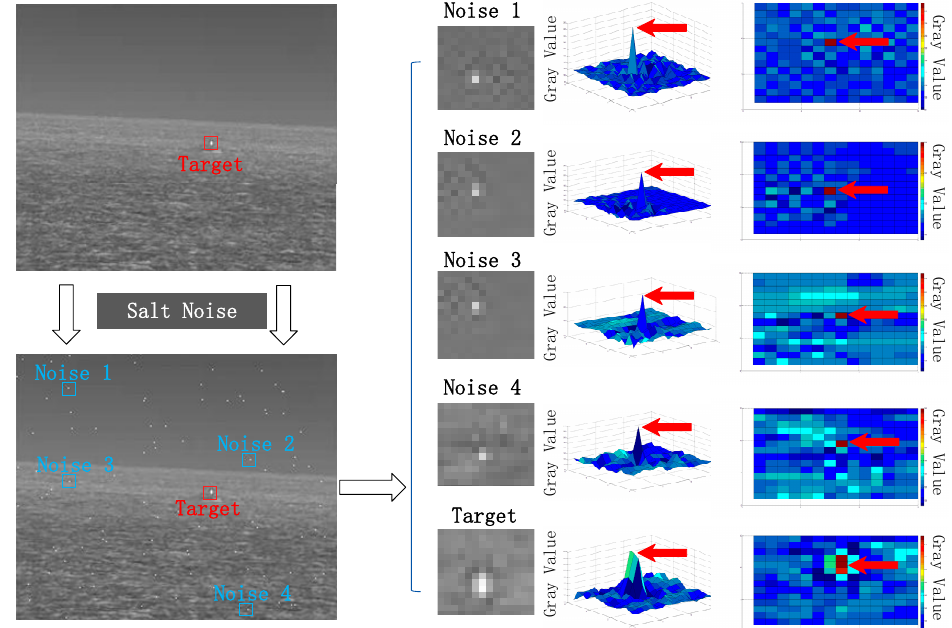
Figure 6. Gray distribution of target and salt noise.